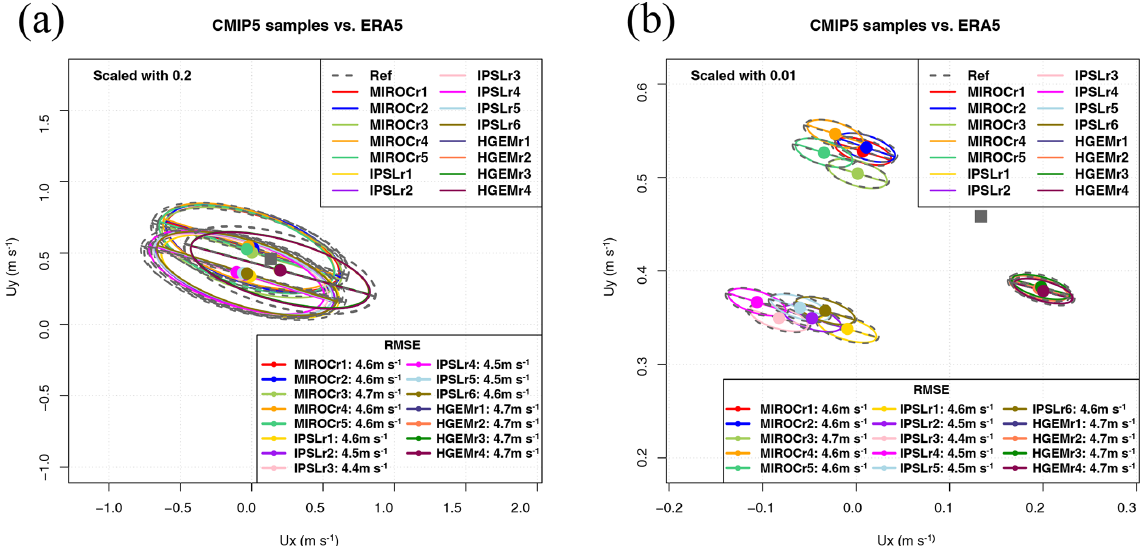
Figure 9. Sailor diagram representing the agreement between the Southern Hemisphere wind field as simulated by three models from the CMIP5 repository with ERA5 data when the reference dataset is repeated in an extended matrix (a) or when the individual realizations of the ensemble are taken as independent datasets (b)